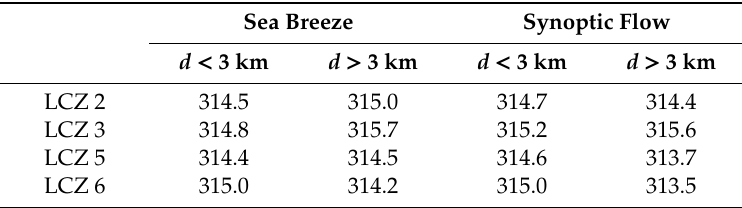
Table 10. Mean land surface temperature (degrees Kelvin) for remotely-sensed